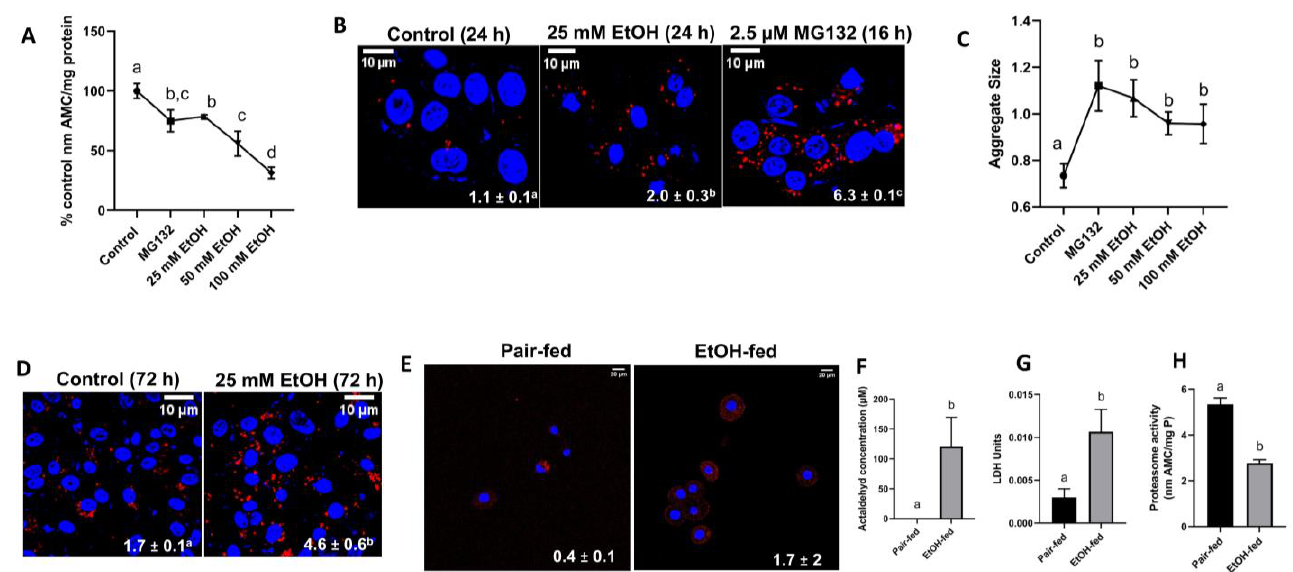
Figure 2. ( A ) Proteasome activity, ( B , D ) protein aggregates, and ( C ) aggregsome size in VL-17A cells exposed to MG132 and/or varying doses of ethanol for the times indicated in the abscissa. ( E ) protein aggregates, ( F ) media acetaldehyde levels ( G ), LDH leakage in incubation media, and ( H ) proteasome activity in hepatocytes isolated from EtOH-fed rats and their pair-fed controls and incubated overnight. On quantification shown at the bottom of micrographs or on line or bar graphs, the same letters (superscripts) are not significantly different. These data containing different letters (superscripts) are significantly different.